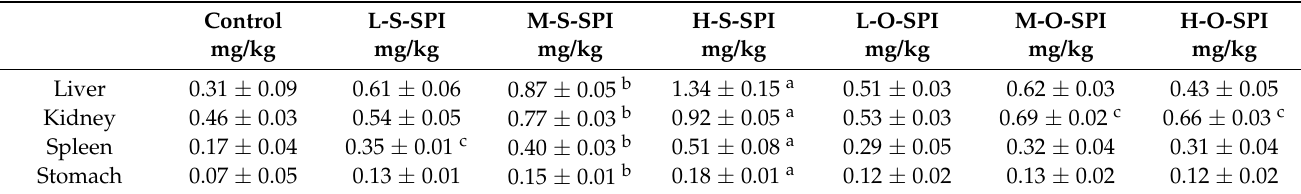
Table 1. Se accumulation in different organ in mice after treated with different dose of protein. Different superscript letters indicate significant difference ( p < 0.05) Se for each